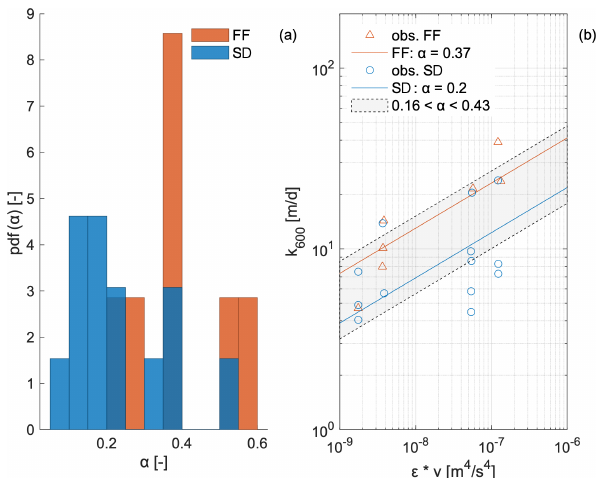
Figure 3. Panel (a) contains the probability density function (PDF) of the α coefficient calibrated for each saturation curve for both the flexible foil and standard chamber. Panel (b) shows Eq. (5) obtained for both the standard and the flexible foil chamber in a log–log plot; the coefficient α was calibrated based on the two data sets using the least-square